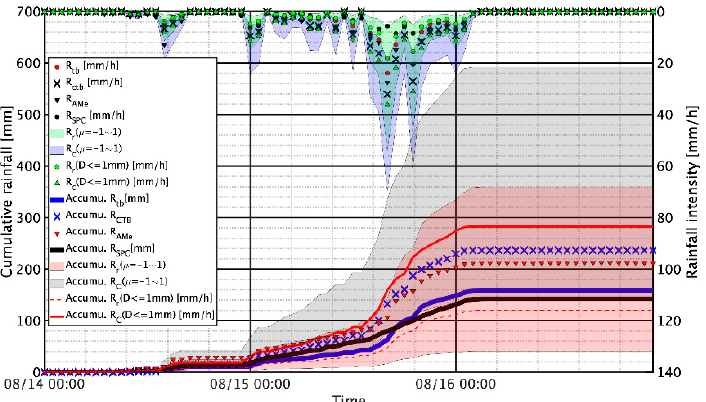
Figure 2. Time series of rainfall intensity and cumulative rainfall from August 14 to 16 in 2019 (JST). Rainfall intensity (right axis) of R tb and R ctb shown in red circles and black crosses, respectively. Rainfall intensity detected at the automated meteorological data acquisition system (AMeDAS) station (R AMe ) is indicated in black triangles, and the intensity calculated from the SPC data (R SPC ) is in black circles. The areas where the estimated results ((Rr(D < 1) and Rc(D < 1)) are described in Section 2.4, are highlighted in blue and green; they depend on the shape parameter ( µ ) values ranging from − 1 to 1. The green circles and triangles represent Rr(D < 1) and Rc(D < 1) with µ = 0. Left vertical axis shows the cumulative rainfall for each component (R tb , R ctb , R SPC , Rr(D < 1) and Rc(D < 1)) from 00:00 14 August (JST). Cumulative rainfall of R tb and R ctb are shown in blue solid line and blue crosses, respectively, and that of R SPC is in black line. Cumulative rainfall of Rr(D < 1) and Rc(D < 1) with µ = 0 are expressed in red solid and dashed lines, respectively. Red area indicates the di ff erence between the shape parameter µ = − 1 and 1 where AMeDAS data points are plotted as red triangles.